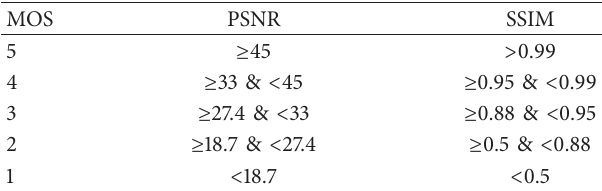
Table 1: Mapping of oQoE to sQoE.